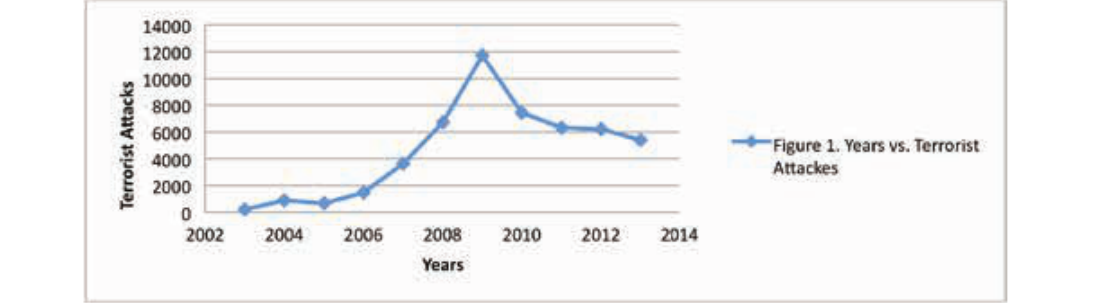
Source: South Asian Terrorism